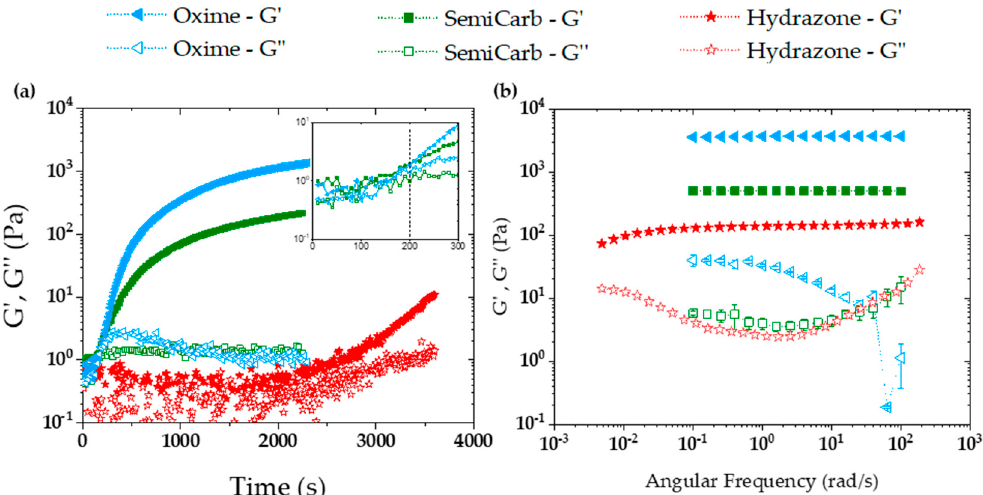
Figure 2. Hydrogel formation kinetics and viscoelasticity exhibited by a series of 2% (w/v) 10% ox-alg samples prepared with different cross-linkers (equimolar). (a) Time sweep using the three different cross-linkers; aminooxy, semicarbazide, and hydrazide for evaluating hydrogels formation kinetics measured at 1% strain and 10 rad/s. (b) Frequency sweep for the same three hydrogels measured at 1% strain.